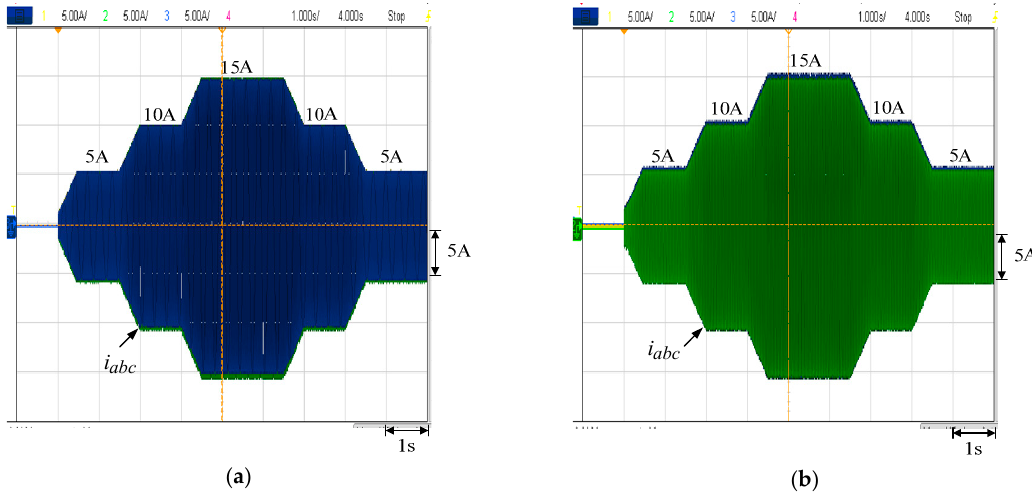
Figure 8. Winding current waveforms of the current command is varying as 0 A → 5 A → 10 A → 15 A → 10 A → 5 A: ( a ) 900 rpm; ( b ) 1500 rpm.